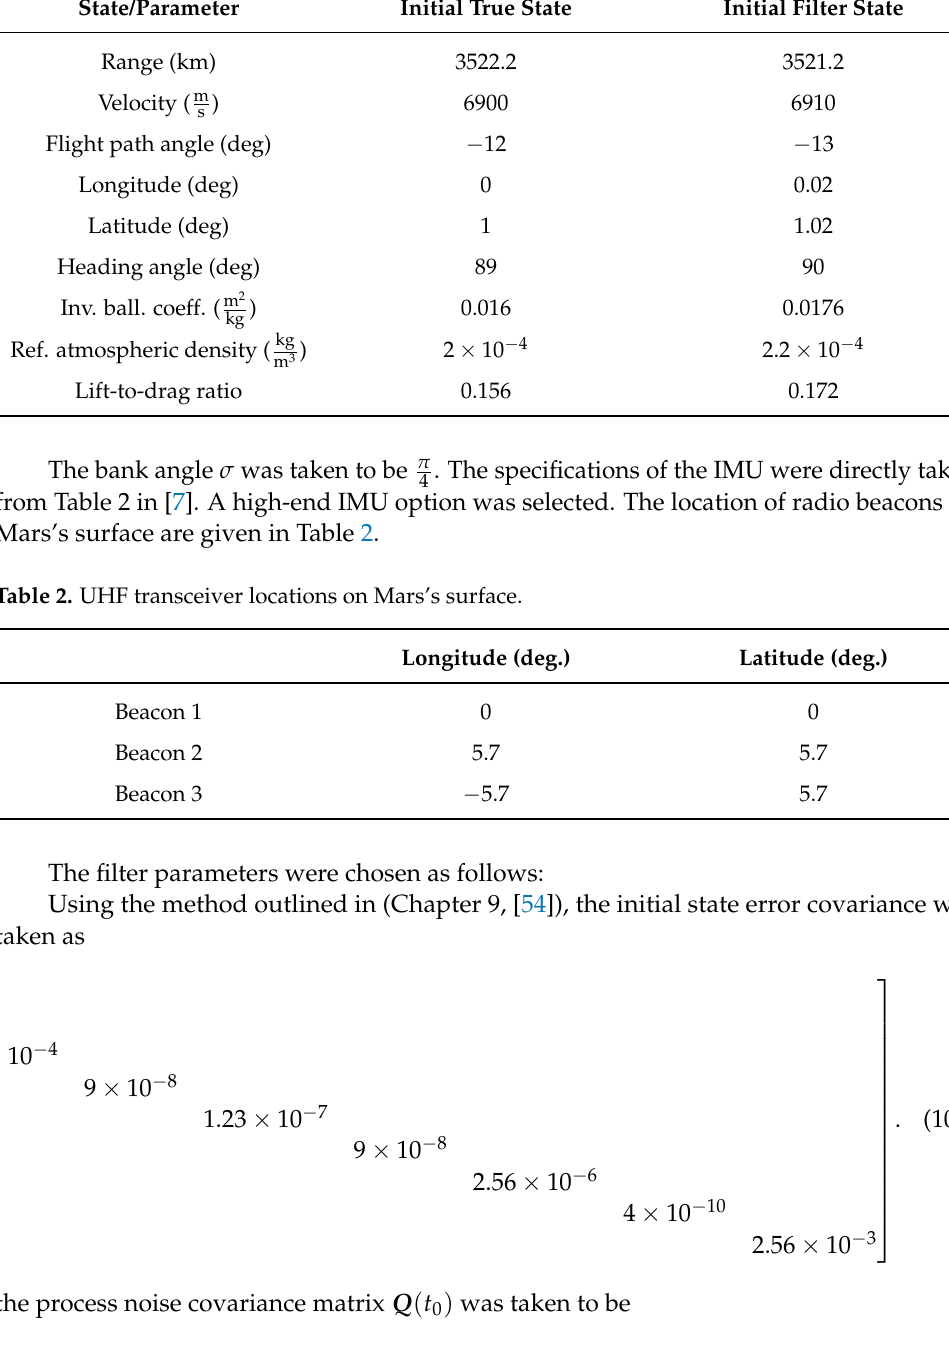
Table 1. True and filter initial conditions for states and parameters used in simulations. State/Parameter Initial True State Range (km) 3522.2 3521.2